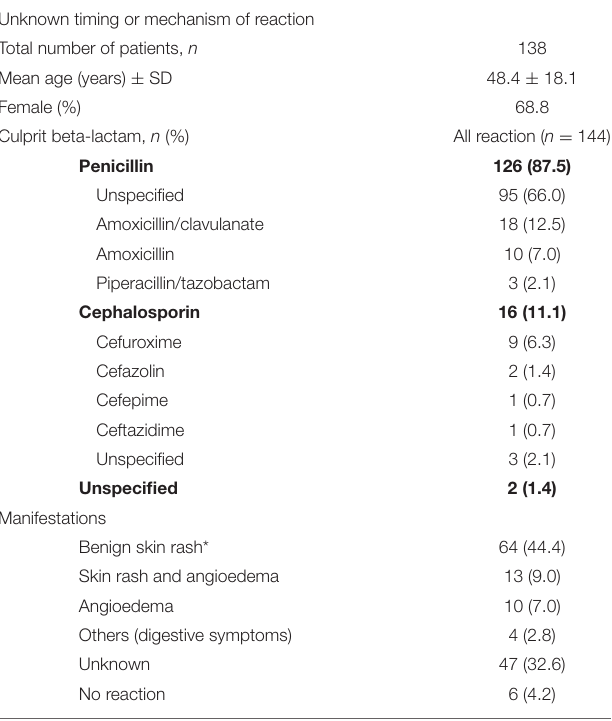
TABLE 2 | Management of patients with a suspected allergy to beta-lactam antibiotics and unknown timing or mechanism of reaction-type. Unknown timing or mechanism of reaction Total number of patients,